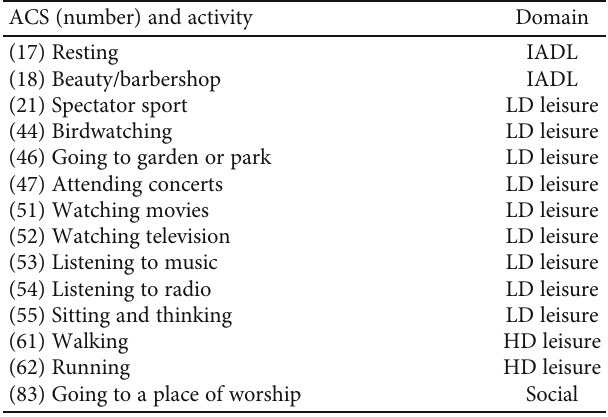
Table 3: Low-cognitive skill activities ( n = 14